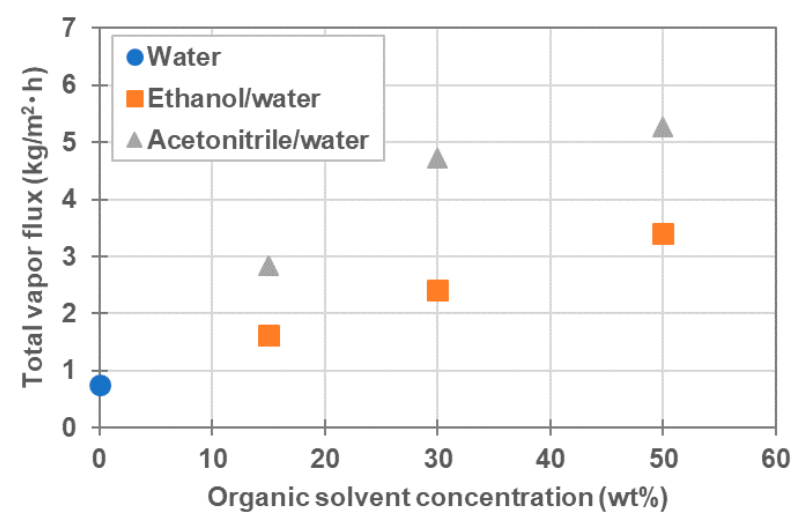
Figure 9. The total vapor flux vs. organic solvent composition of the feed. The data for water was from Table 2.